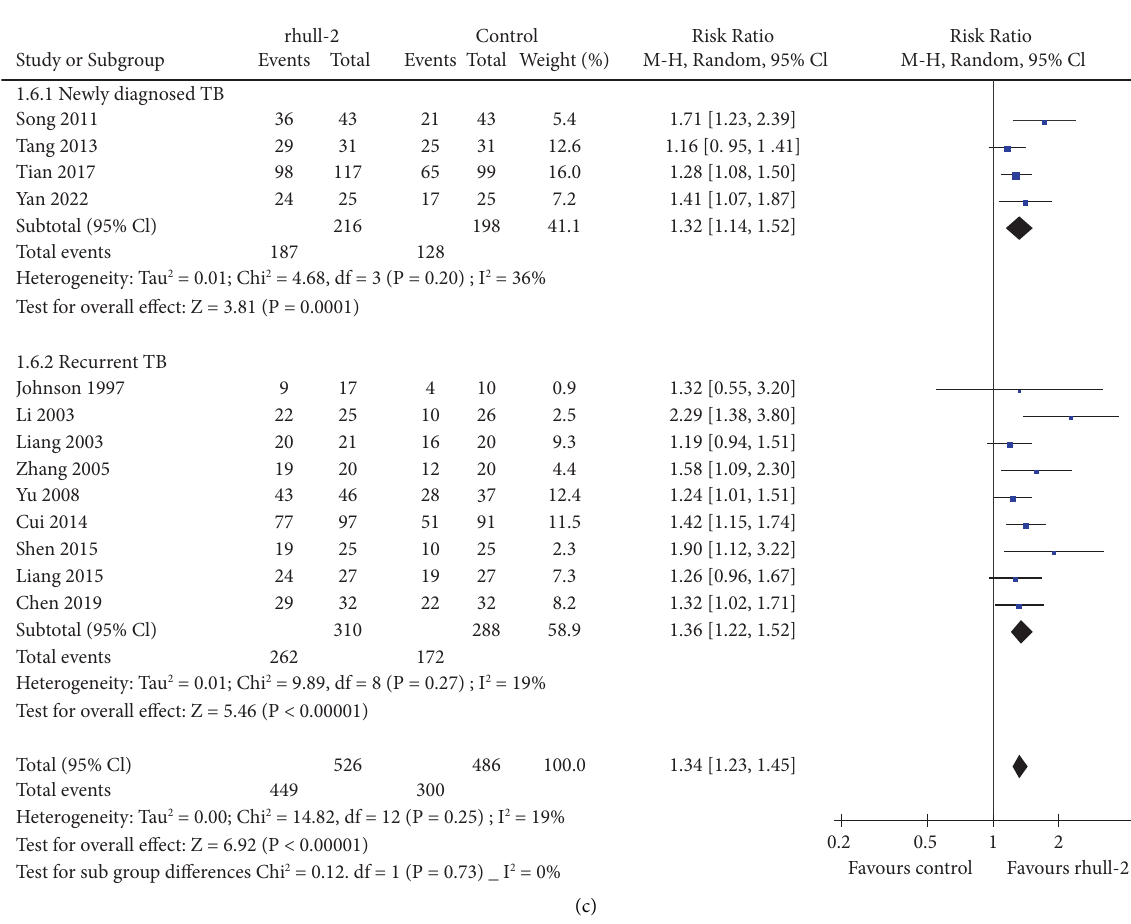
Figure 3: Forest plots for the meta-analysis of the efect of rhuIL-2 on the proportion of patients with sputum smear conversion to negative; (a), forest plots for the overall meta-analysis; (b), forest plots for the subgroup analysis according to the drug sensitivity of TB; and (c), forest plots for the subgroup analysis in newly diagnosed and recurrent TB. Table 3: Univariate meta-regression analyses for the association between patient and treatment characteristics with the efcacy outcomes. RR for sputum culture conversion to negative